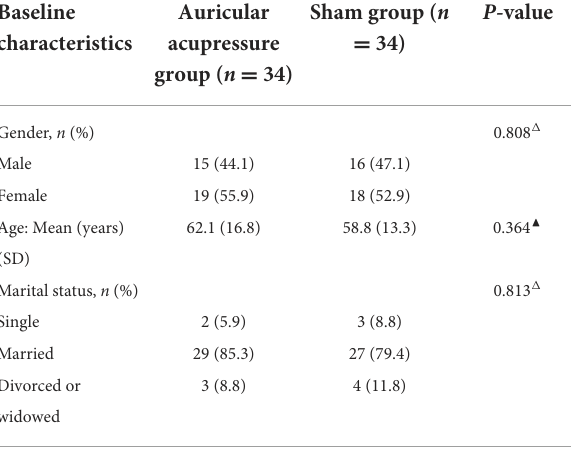
TABLE 1 Participants’ demographic